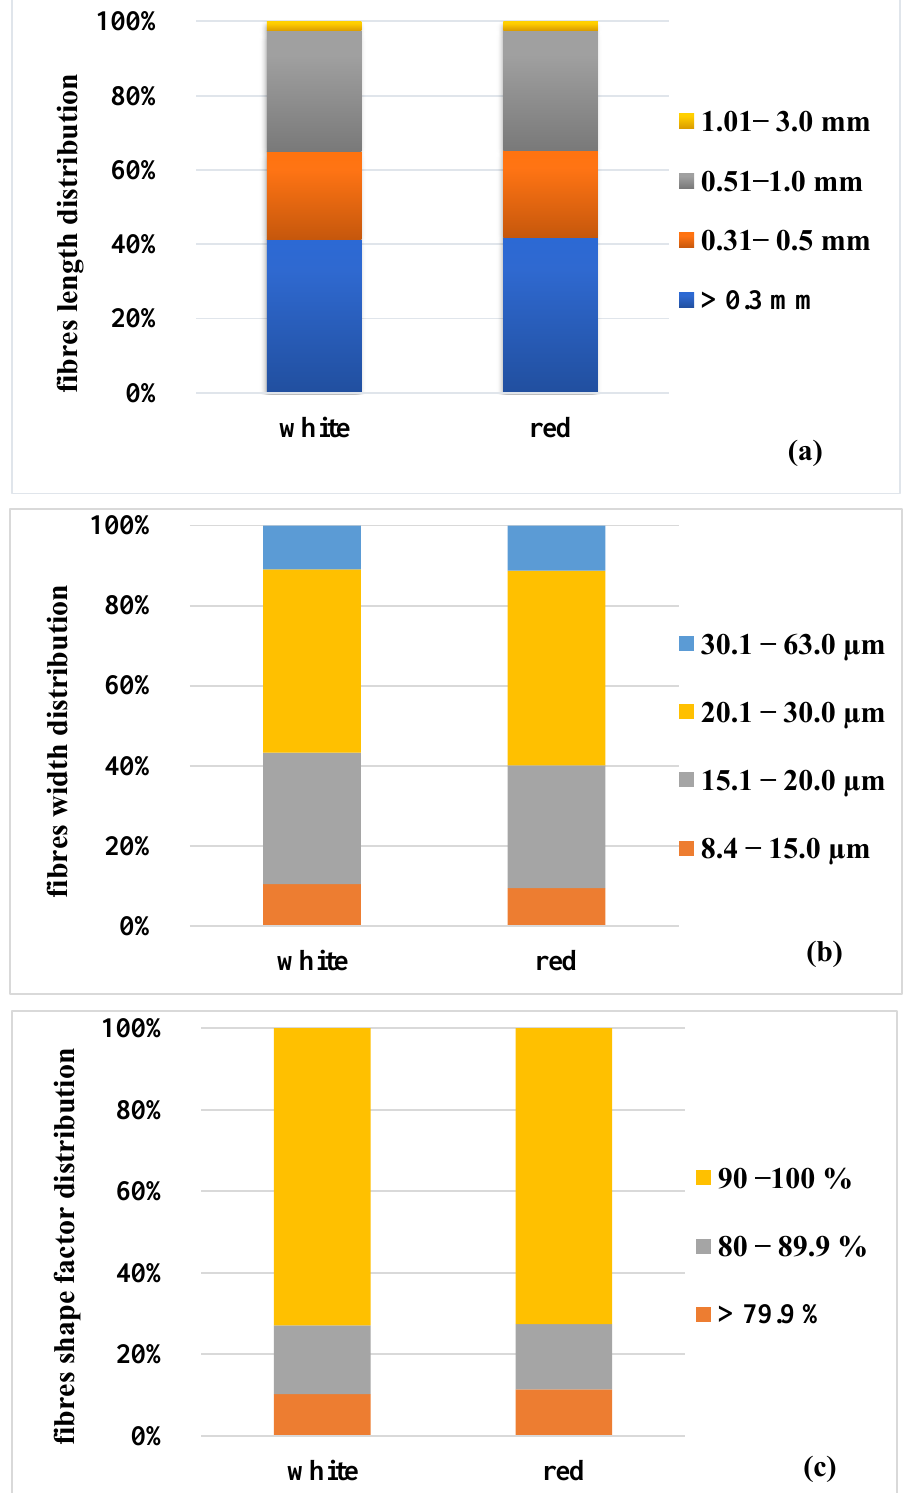
Figure 5. Fiber characteristics of grape cuttings: ( a ) fiber length distribution; ( b ) fiber width distribution; ( c ) fiber shape factor distribution.